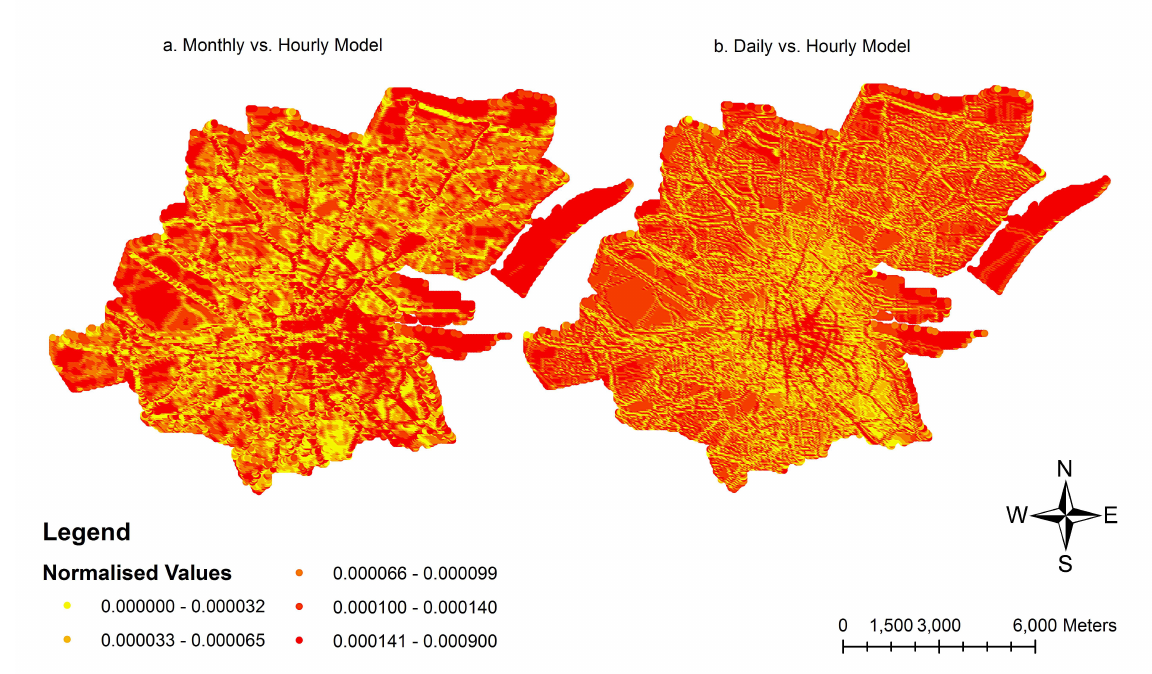
Figure 5: Map showing the spatial variation of the model prediction by hourly H model vs. a. monthly M model and b. daily D